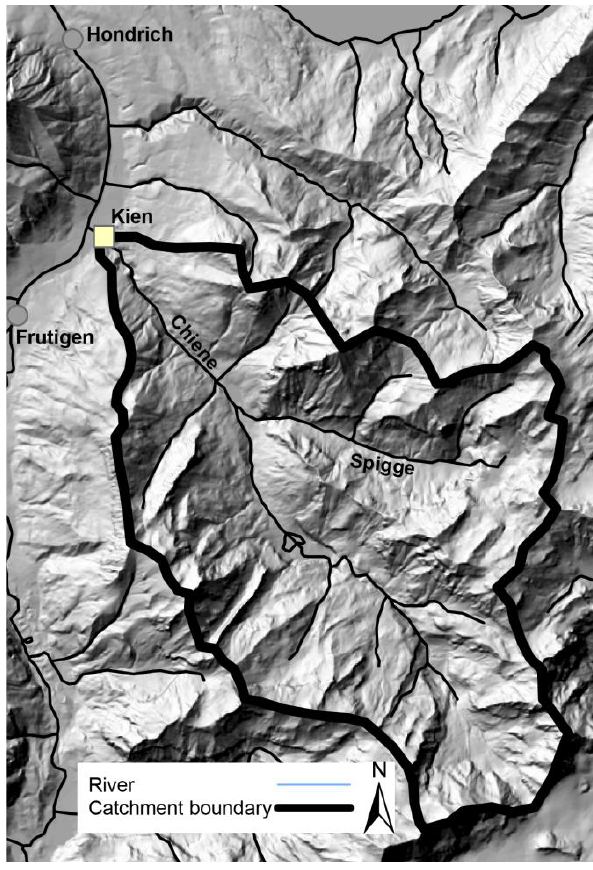
Fig. 1: Chiene catchment area and location of gauging stations for discharge reconstruction. Fig. 1. Chiene catchment area and location of gauging stations for discharge